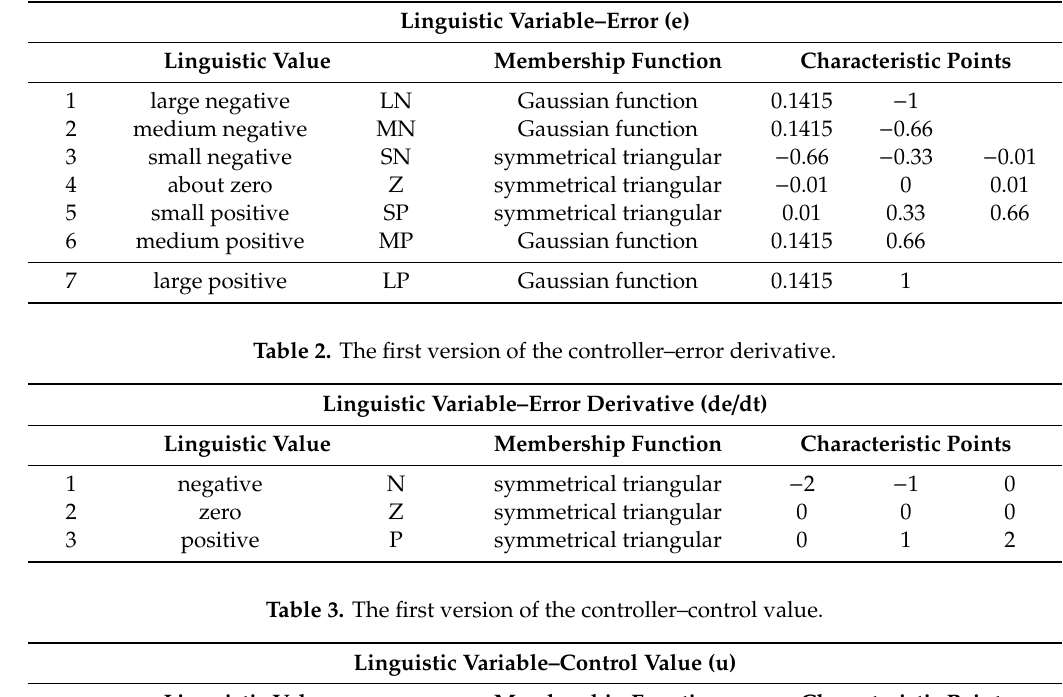
Table 1. The first version of the controller–error.